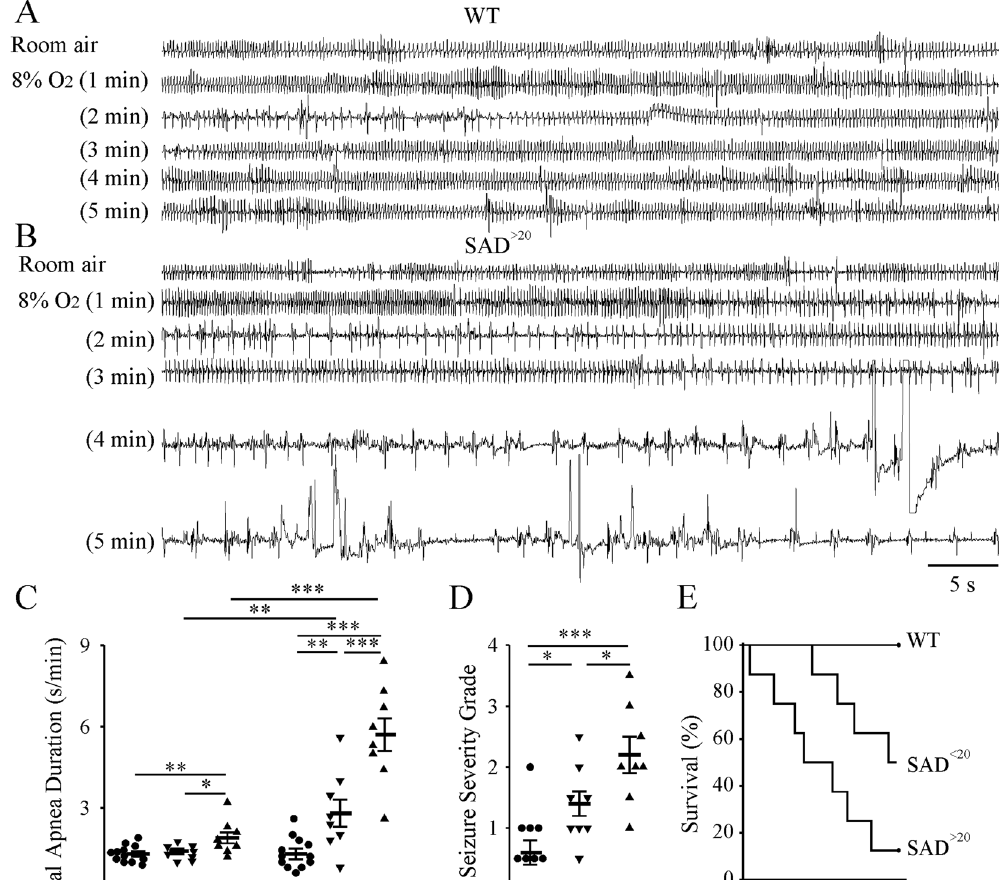
marked seizures (n = 12). By contrast, SAD mice had an initial increase in V E followed by period of marked apneas and behavioral seizures. Total apnea duration increased in SAD < 20 (n = 8, 2.8 ± 0.5 s/min, p = 0.001) and SAD > 20 (n = 8, 5.7 ± 0.6 s/min, p < 0.001) after 5 min hypoxia compared with WT after hypoxia (1.3 ± 0.2 s/min) and mutant in room air. Hypoxia-induced apnea and seizures were more severe in SAD > 20 than SAD < 20 mice (Fig. 2D). Further, all 10 WT, 4 of 8 SAD < 20 and only one of 8 SAD > 20 mice survived during the 30 min exposure to 8% O 2 with a significant difference in survival time (Fig. 2E). The response of SAD mice to 8% O 2 at 7–8 months (Fig. 3), but not at 2–5 months of age (not shown), was dif- ferent from WT mice. In response to 5 min 8% O 2 , WT mice (n = 13) had sustained increase in V E (233.4 ± 11.8% relative to room air) and regular occurrence of sighs (large amplitude breaths often followed by brief apnea: total apnea duration of 2.4 ± 0.2 s/min) without marked behavioral seizures. Compared with WT mice, hypoxia caused a blunted V E increase (169.8 ± 10.6% relative to room air, p = 0.016), accompanied by increased apnea duration (6.3 ± 1.1 s/min, p < 0.001) in SAD T (n = 14), but not SAD NT mice (n = 13). Hypoxia induced observed behavioral seizures occurred in most mutants and were more severe in SAD T than SAD NT mice. Further, 1 of 8 SAD T died, but all 8 SAD NT and 10 WT mice survived during 1 hour of 8% O 2 challenge.